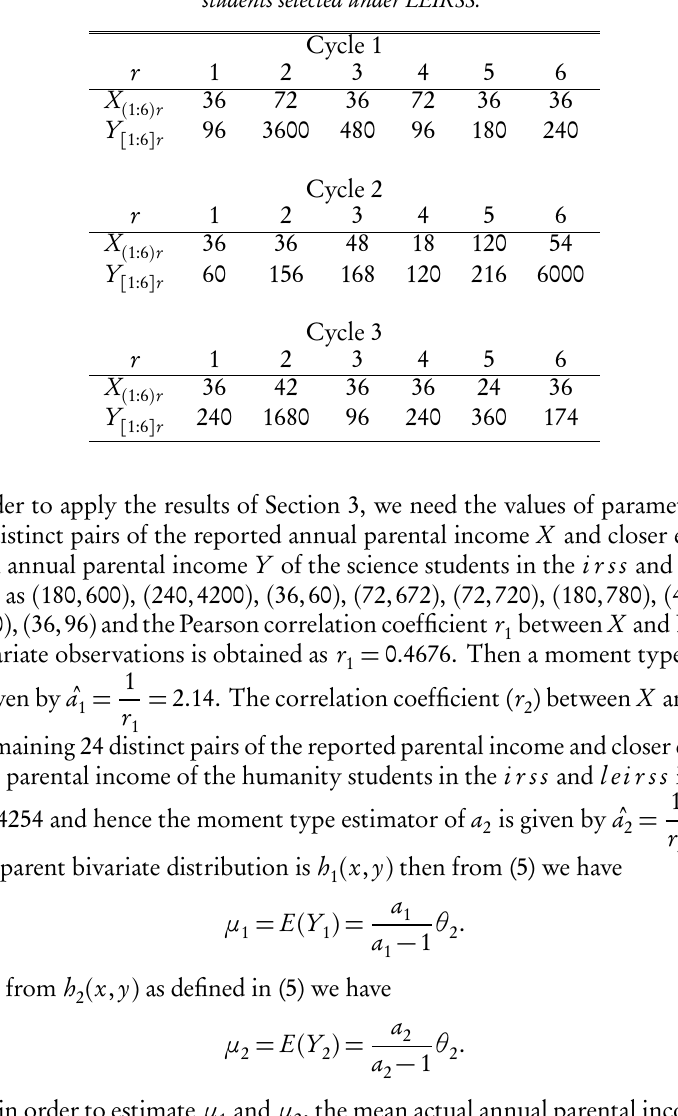
Reported annual parental income and the closer estimate of actual annual parental income of students selected under